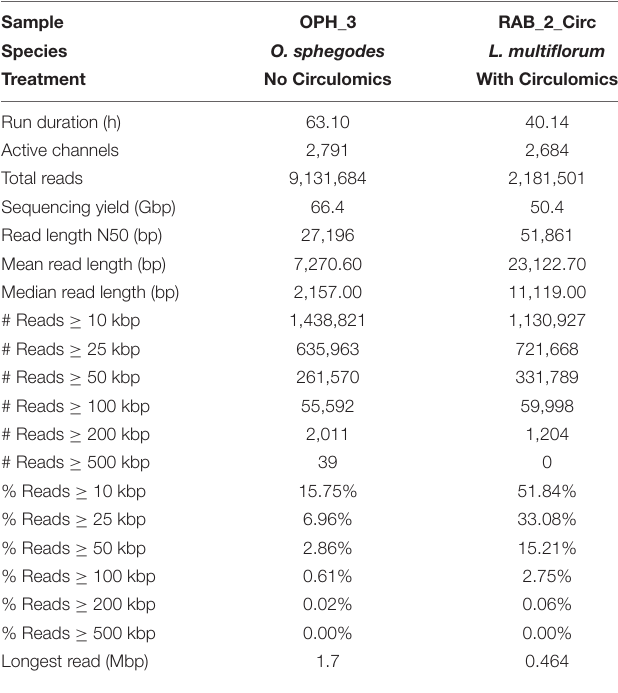
TABLE 2 | Nanopore (PromethION) sequencing statistics for sequenced